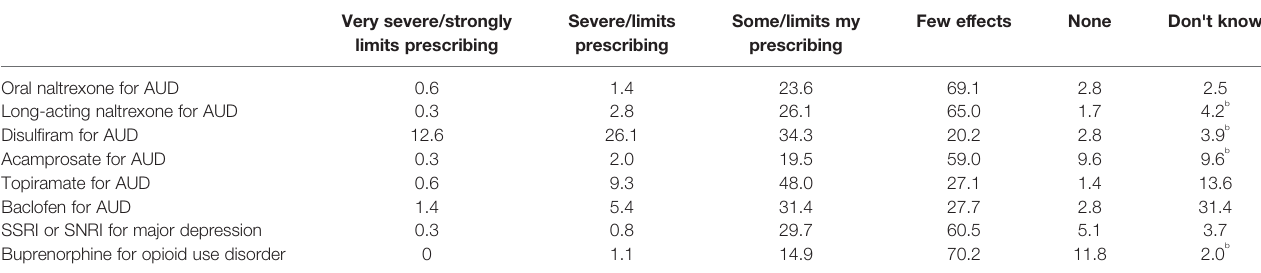
TABLE 3 | Prescribers ’ ratings of the severity of side effects of medications for alcohol use disorder (AUD) and other psychiatric medications (n=354) a